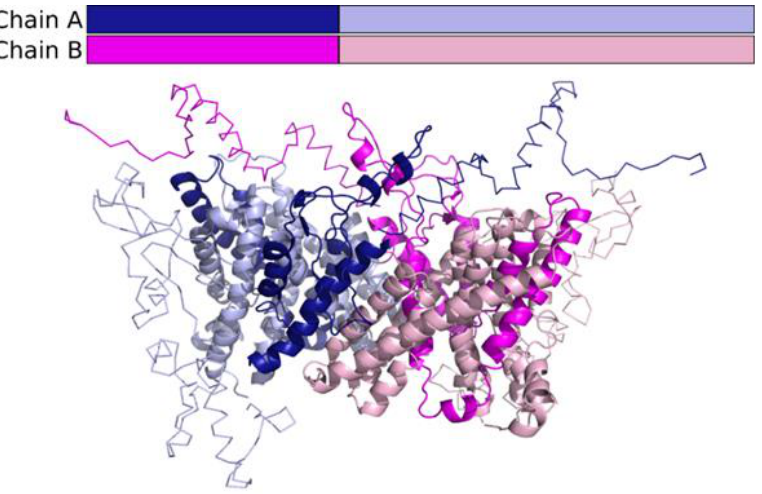
Figure 3. Regions corresponding to the truncated mutant protein (dark colours) in the context of the structure model of the SCL9A6 dimer. Regions predicted as disordered are shown in ribbon representation, and the structured part of the protein is shown in cartoon.